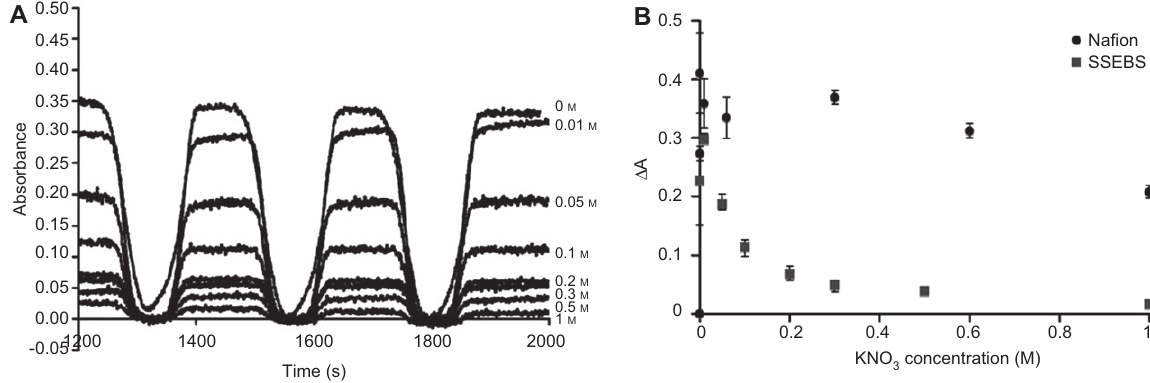
Figure 15 Optical modulation of 0.1 m m [Ru(bpy) (A) polystyrene-block-poly(ethylene-ran-butylene)-block-polystyrene (SSEBS)/ITO electrodes after 30 min of exposure to analyte solution. Comparison of change in absorbance for 0.1 m m [Ru(bpy)